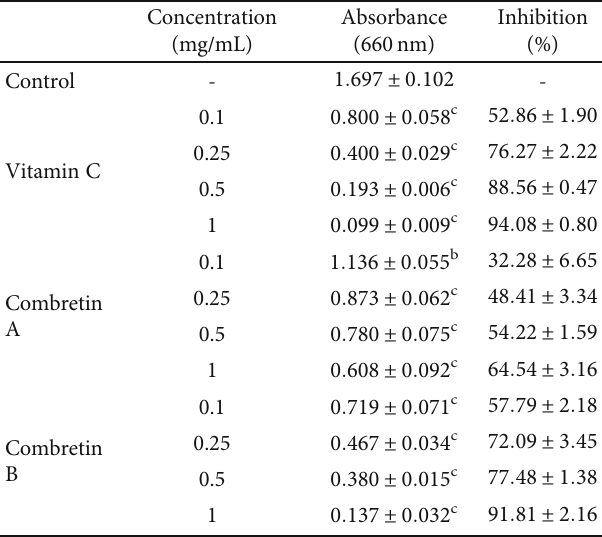
Table 2: E ff ect of Combretin A and Combretin B on nitric oxide scavenging